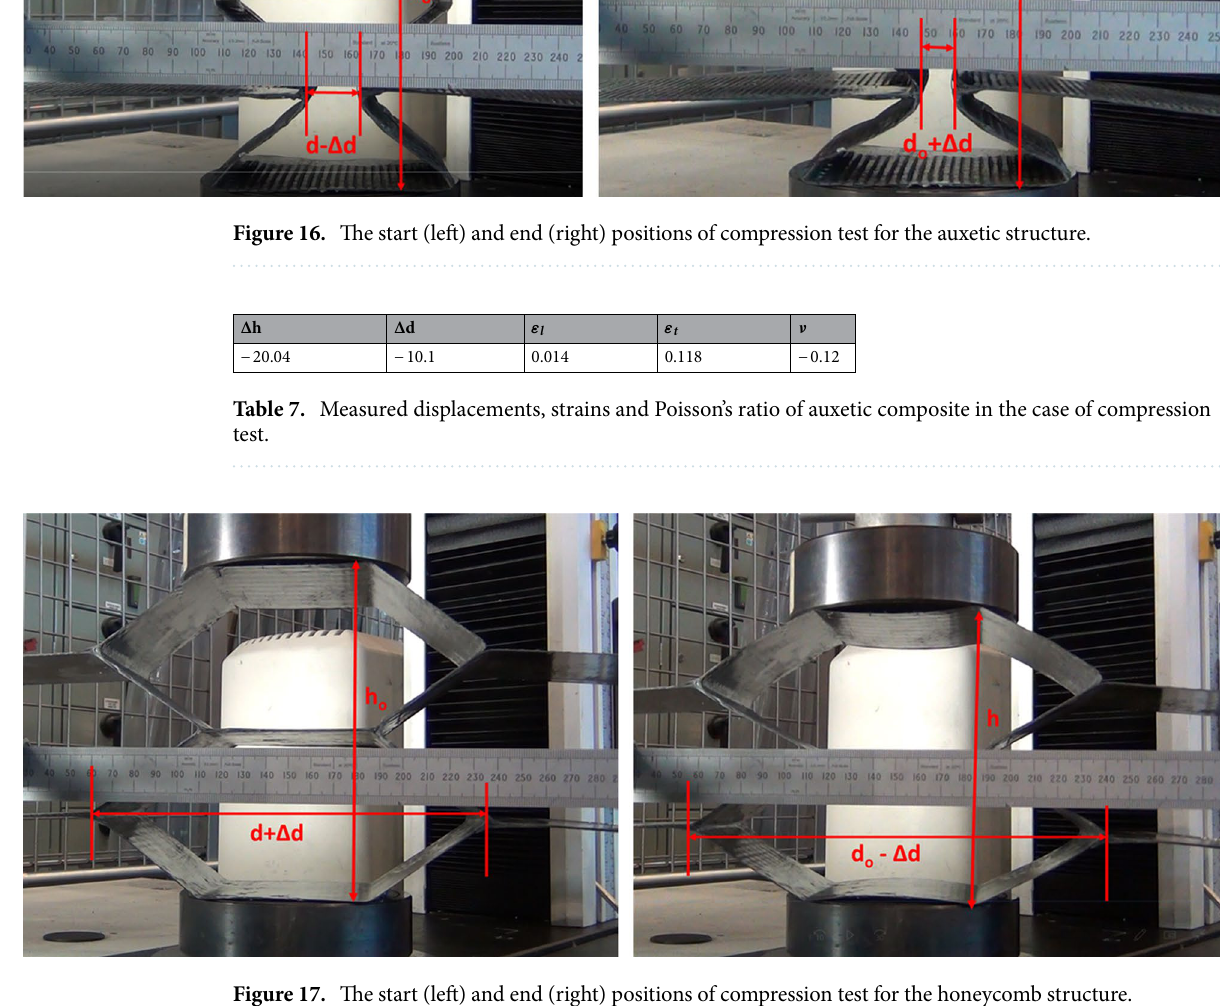
Figure 17. The start (left) and end (right) positions of compression test for the honeycomb